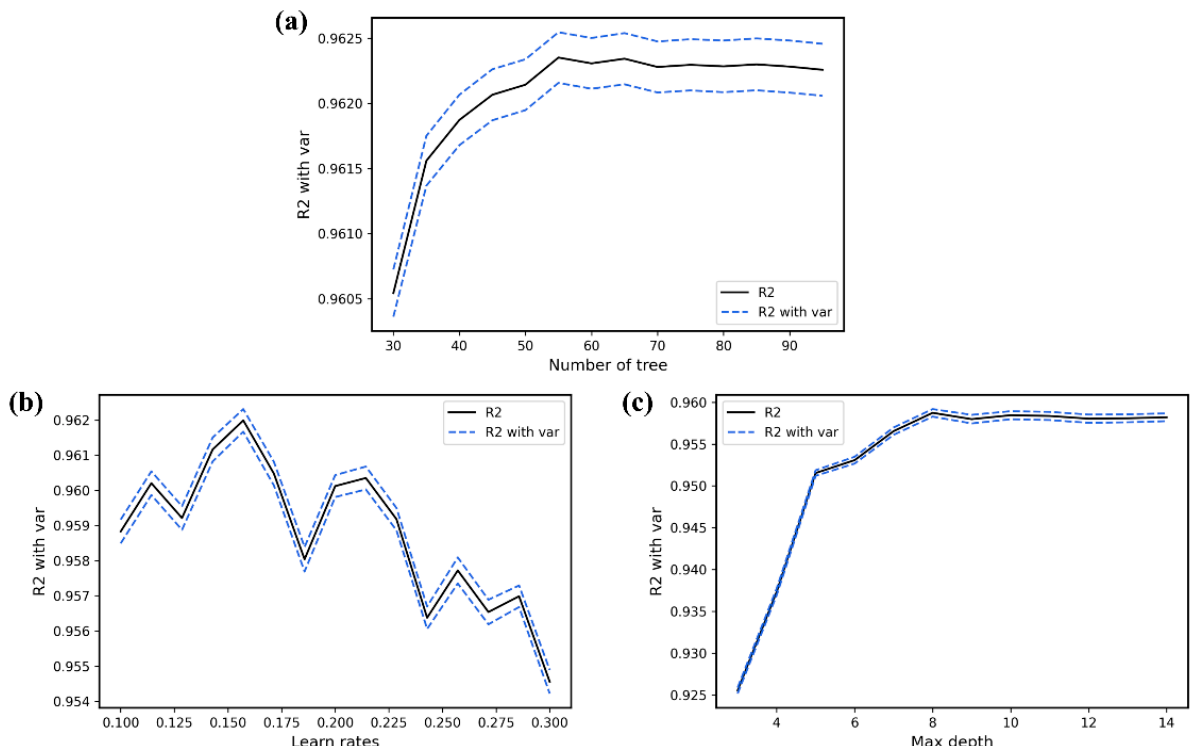
Figure 4. R 2 values for different parameter values in the improved XGB model. ( a ) nTree values from 1 iterate to 100, ( b ) learn rate from 0.1 iterates to 0.3, ( c ) max depth from 3 iterates to 15.